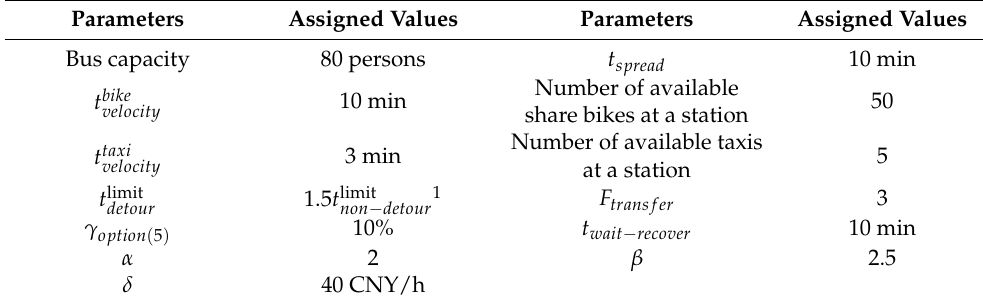
Table 7. Assigned values of some parameters in the